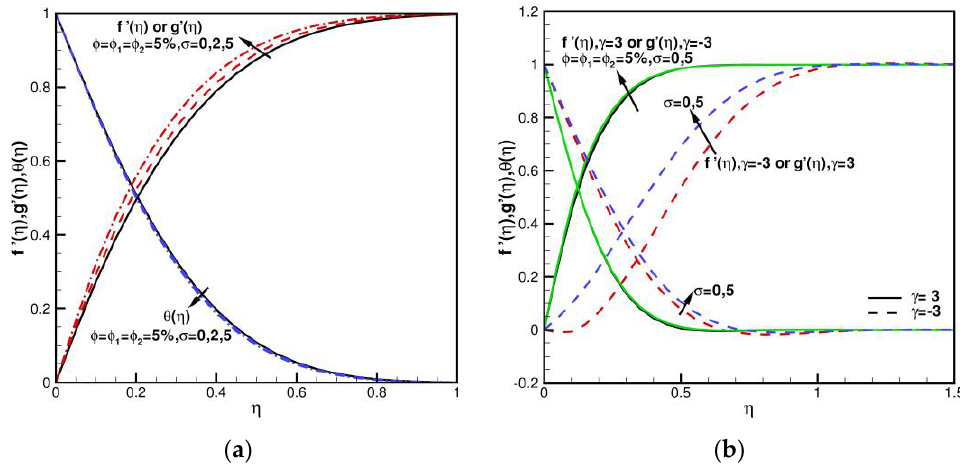
Figure 4. The dimensionless velocities and temperature distributions of f (cid:48) ( η ) , g (cid:48) ( η ) , θ ( η ) when φ = φ 1 = φ 2 = 5% and Pr = 6.2. ( a ) Impact of γ = 0, σ = 0, 2, 5; ( b ) Impact of γ = − 3, 3, σ = 0, 5.